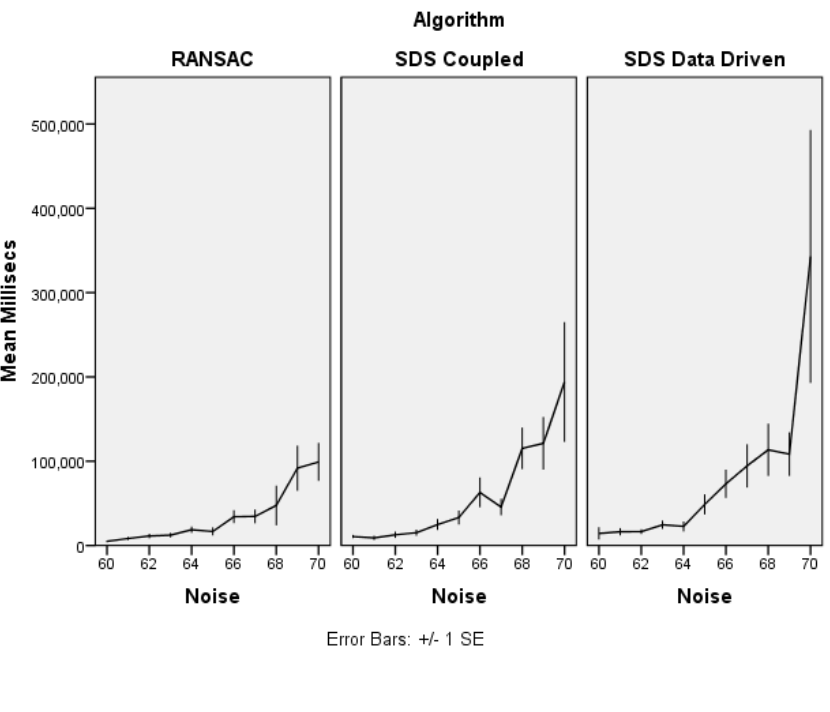
Figure 6. Hyperplane estimation noise trials: